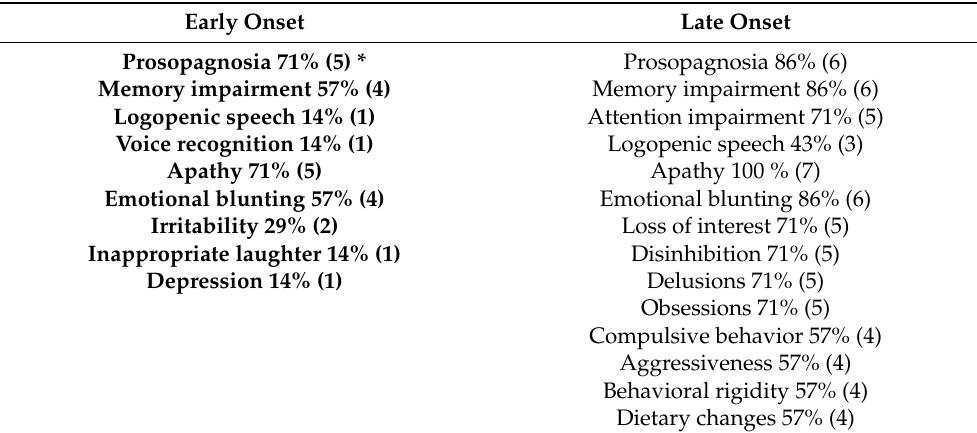
Table 1. Main early-onset and late-onset cognitive and behavioral symptoms of right temporal variant of frontotemporal dementia (rtv-FTD) patients, with the cut-off of one year since the appearance of the first cognitive or behavioral symptom clinically related to frontotemporal dementia